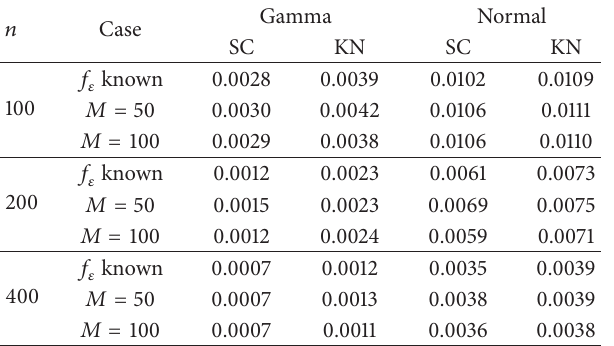
Table 2: MISE for the self-consistent estimator and the kernel estimator when the error distribution is normal.